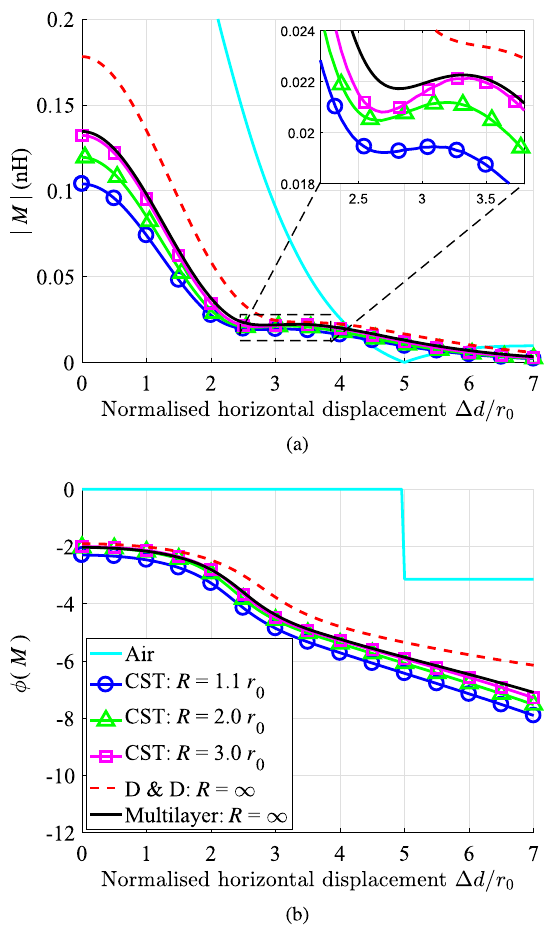
Fig. 6. Mutual inductance ( M ) of two circular coils of radius of r 0 = 11mm and spaced apart d = 37mm inside a conductive medium with conductivity of s = 10S/m as a function of the normalised horizontal displacement D d = r 0 . (a) Modulus and (b) phase of M obtained by the multilayer solution are compared with D&D solutions [21] and CST MWS simulation results for three different sizes of the insulating boxes. The mutual inductance of two coils in free space (air) is also